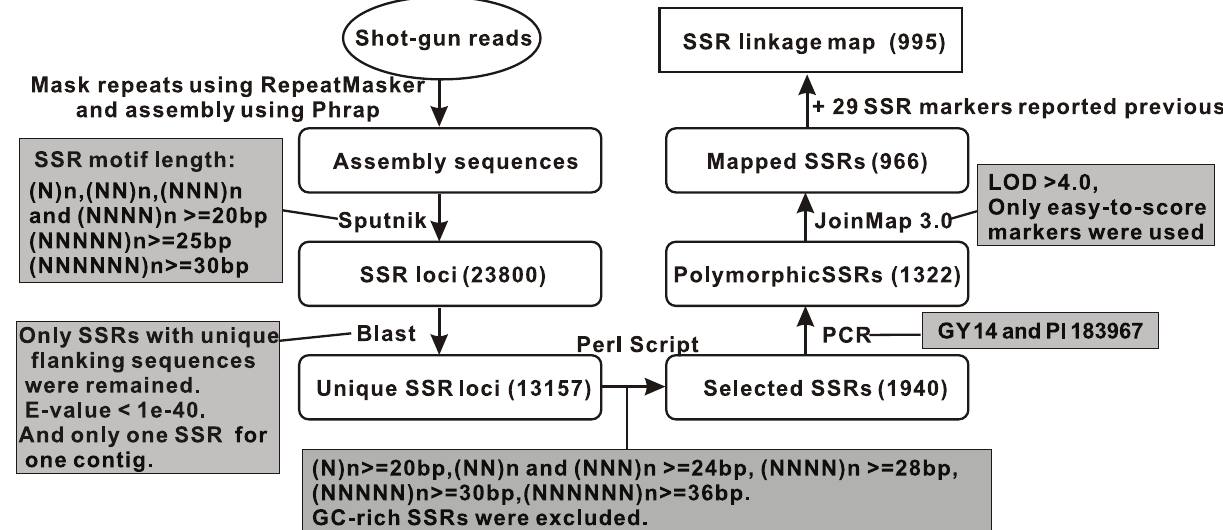
Figure 1. Flow chart of development of cucumber SSR markers.